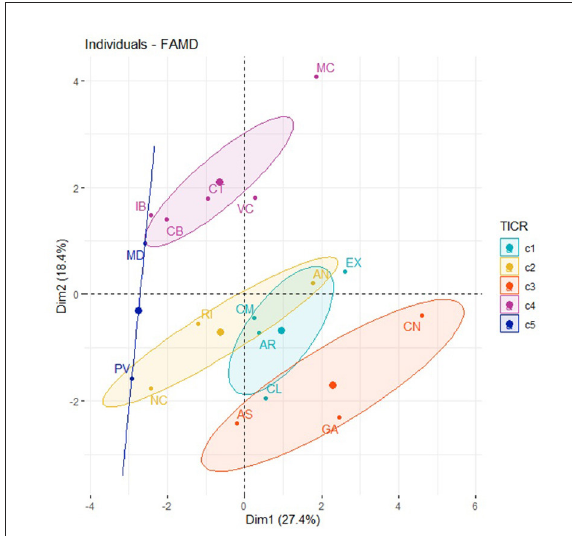
FIGURE8 Factor map of the ACS, Dimension 3, Dimension 4, and the TICR.